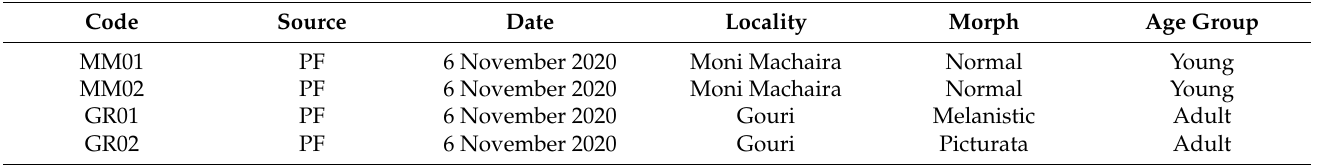
Figure 4. ( a ) Young individual basking on rock, half emerged out of water. ( b ) Shed skin of the species with emphasis on the characteristic keeled scales (indicated with red arrow). ( c ) Large individual of the picturata morph lying underwater in a small pond ©Tassos Shialis. ( d ) Young individual of the normal morph eating a small frog in the dry riverbank ©Christina Kakoulli. Table 2. Individuals of the critically endangered species N. n. cypriaca that were recorded in this study, either as primary findings (PF) or as citizen science records (CS) provided by volunteers. In total 12 of the 13 records are outside of current species distribution, providing new knowledge on the distribution of the species in the Troodos Mountains.